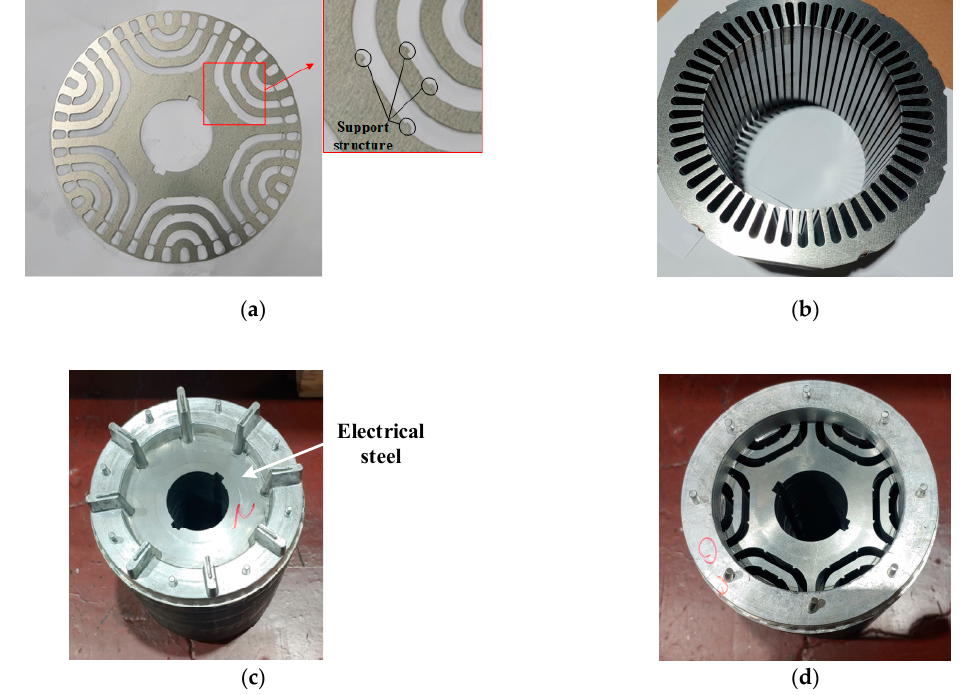
Figure 14. Manufacture LS-PMA-SynRM: ( a ) rotor core, ( b ) stator, ( c ) rotor before removing the electrical steel, and ( d ) rotor after removing the electrical steel.